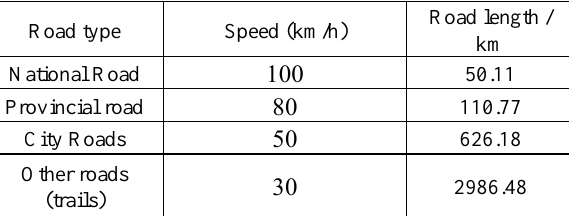
Table 1. Road types - Road speed - Road length.